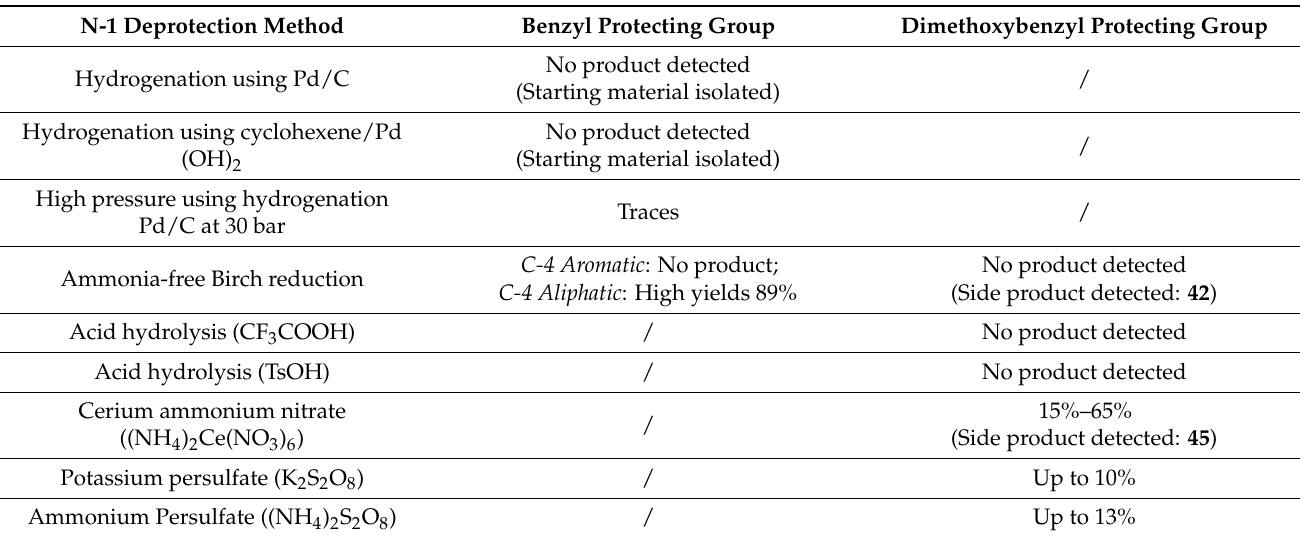
Table 1. Unsuccessful and successful methods for removal of N-benzyl protecting group and N - dimethoxybenzyl protecting